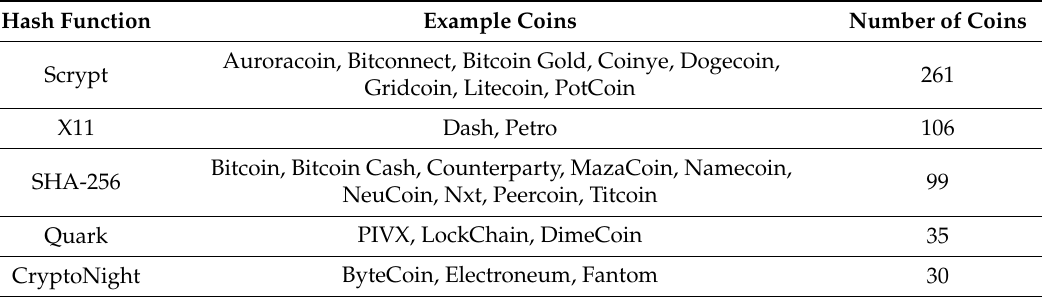
Table 2. Top 10 hash functions for blockchain-based coins